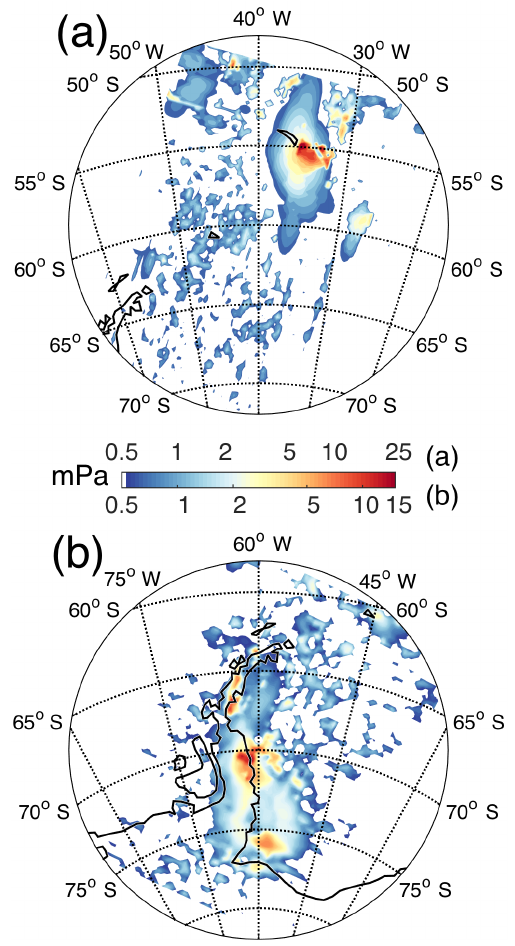
Figure 7. As Figs. 5h and 6h but for estimates of the magnitude of gravity wave momentum flux over South Georgia (a) and the Antarctic Peninsula (b) calculated without correcting for attenua- tion of wave amplitude as discussed in Sect. 5. Momentum fluxes less than 0.5mPa are coloured